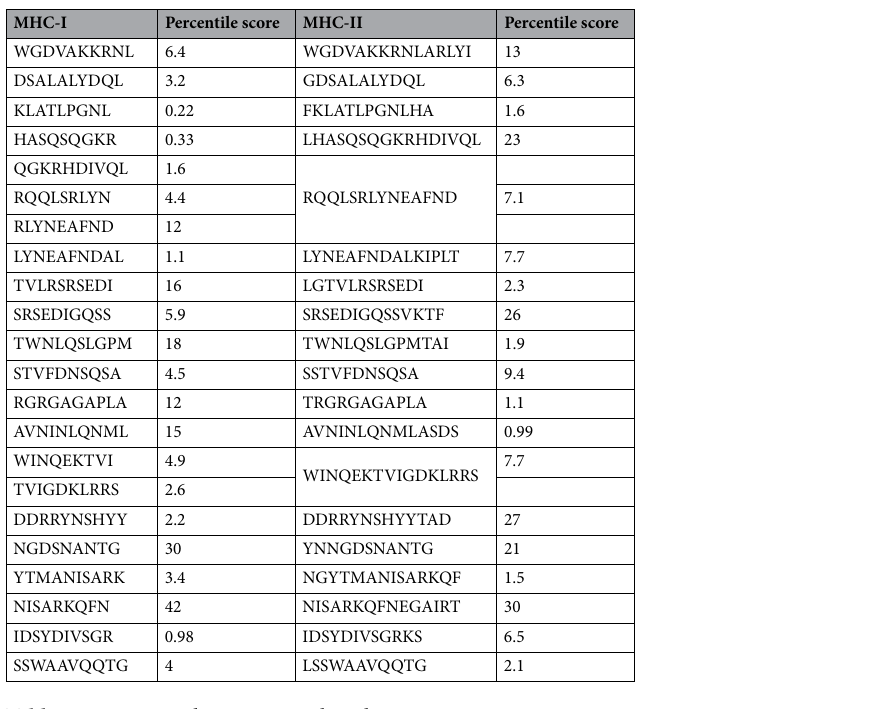
bility analysis. In order for the immune system to function properly, vaccines must bind to immune cell receptors. DRB*0101 analysis later investigated the potential to bind with HLA DRB*0101 allele at all selected epitopes 54 . However, only those epitopes that had an IC50 lower than 100 nM were considered for further analysis.